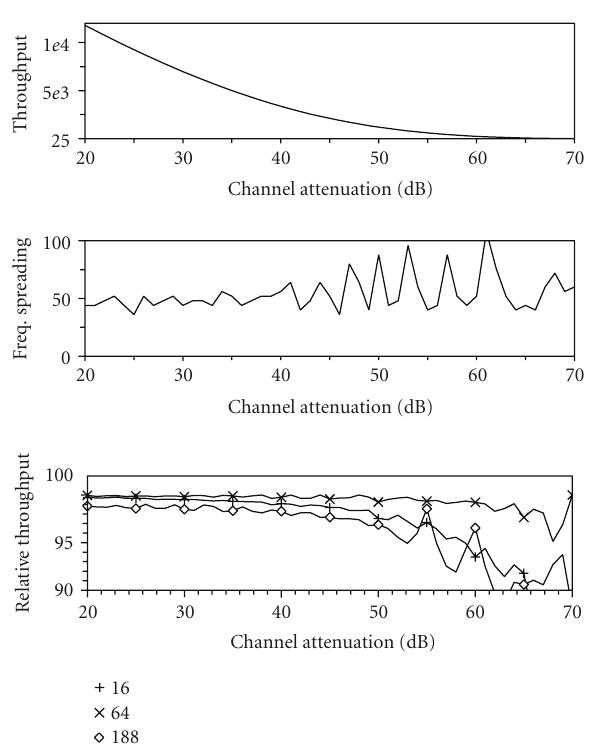
Figure 9: Maximal throughput max( R ) in bit per SS-OFDM sym- bol, corresponding code length, and relative throughput R/ max( R ) for three code lengths L f = { 16,64,188 } of SS-OFDM with L t = 1 versus channel attenuation in dB, over PLC channel no. 1.